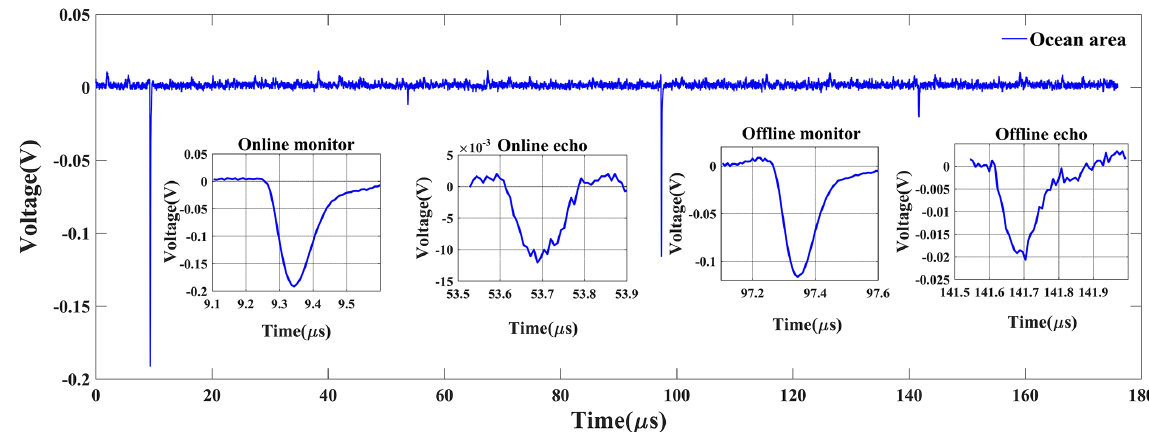
Figure 4. Original echo signal of ocean area (total signal and pulse amplification signal). The amplification signals from left to right are online monitor signal, online echo signal, offline monitor signal, and offline echo signal.